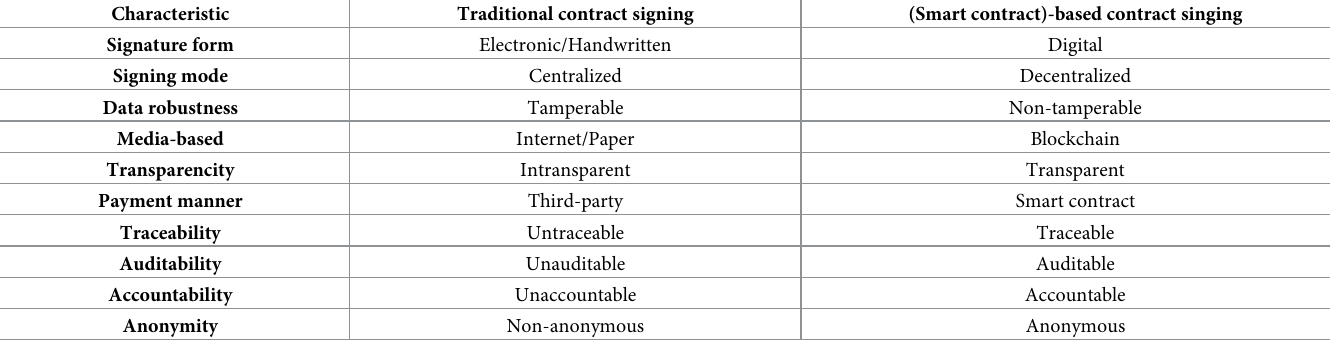
Table 1. The comparison between (smart contract)-based delegate contract signing and traditional delegate contract signing.